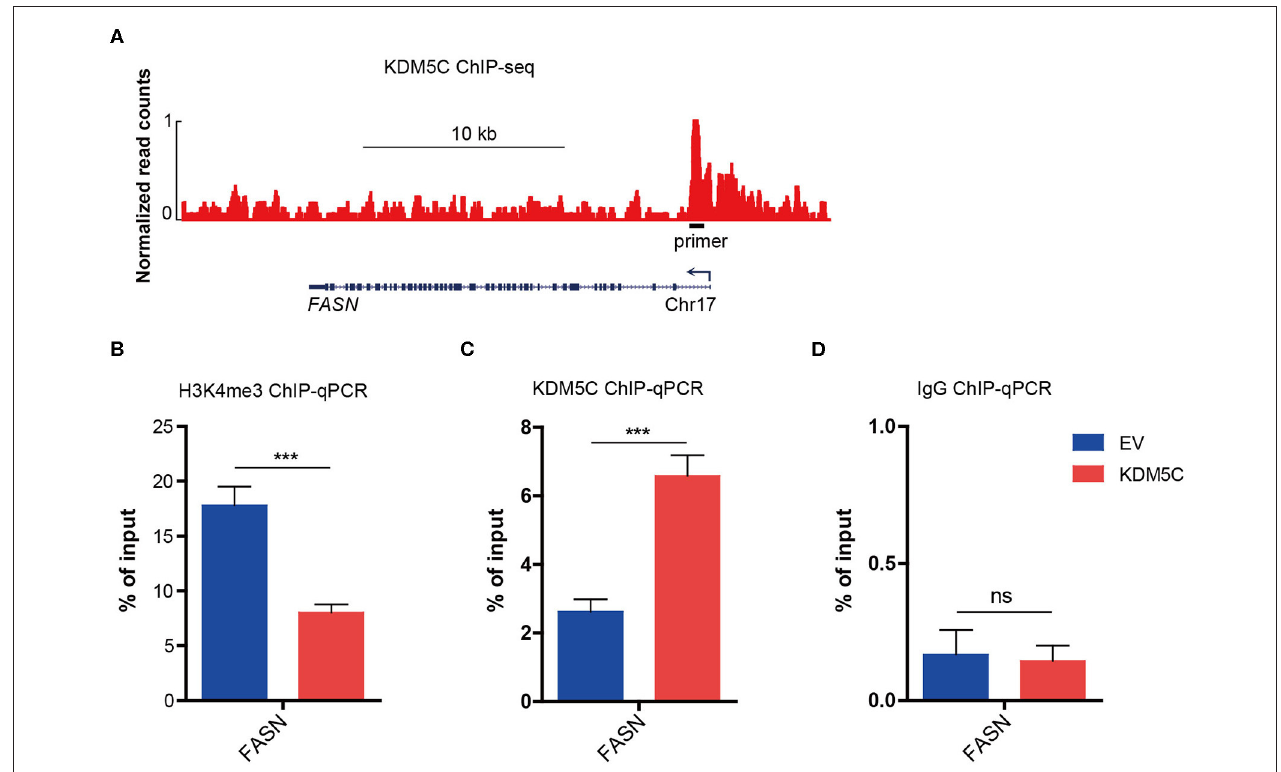
FIGURE 5 | KDM5C regulates dynamic H3K4me3 modifications in the promoter region of FASN. (A) Genome browser track representing the binding sites of KDM5C at FASN gene locus in breast cancer cells. (B–D) ChIP-qPCR assay of H3K4me3 (B) , KDM5C (C) or IgG (D) occupancy at FASN gene locus in HCCC9810 cells transduced with control or KDM5C-expressing vector. Data are presented as the mean ± SD. *** p < 0.001. All results are from three independent